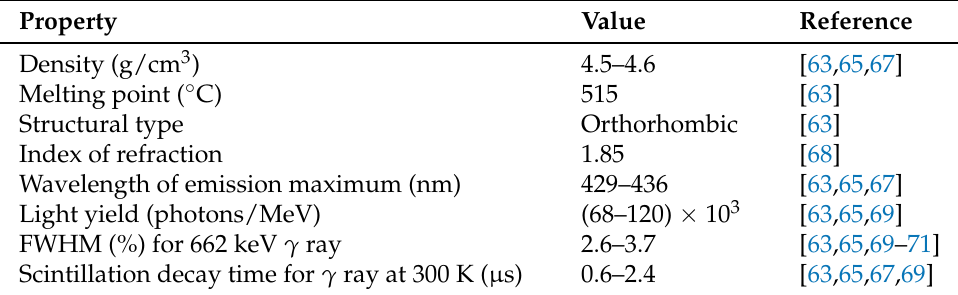
Table 1. Properties of SrI 2 (Eu) crystal